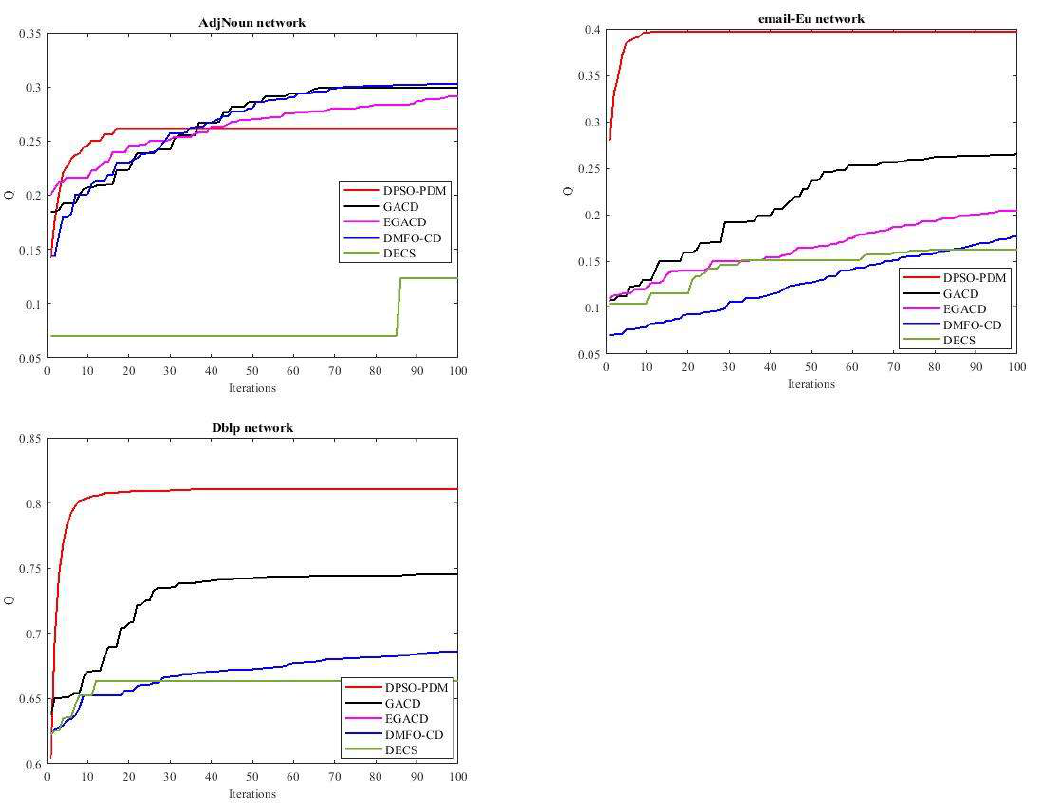
Figure 12. Convergence curves of the proposed DMFO-CD and comparative algorithms.